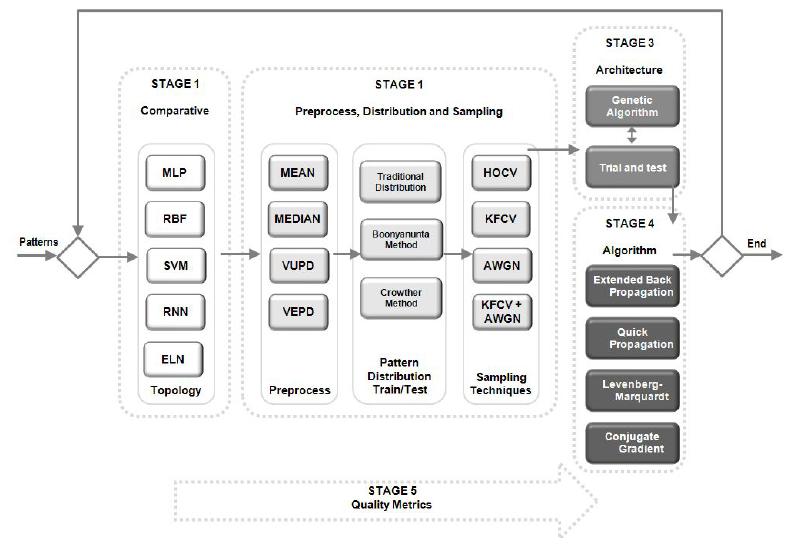
Figure 3: Optimization Methodology based in neural